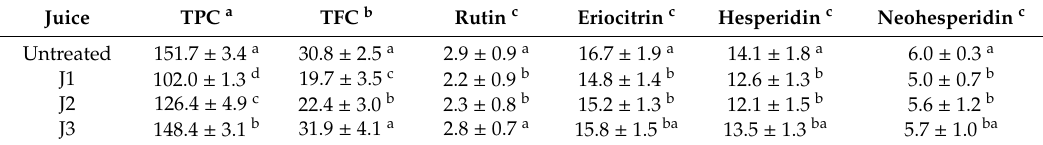
Table 2. E ff ect of di ff erent pressure on TPC, TFC and selected markers quantified by HPLC. Juice TPC